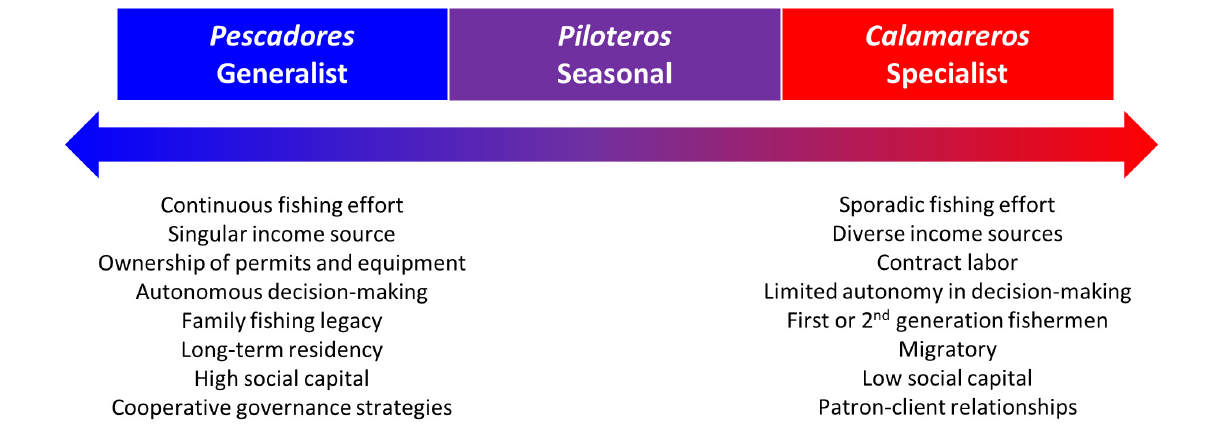
Frontiers in Marine Science |